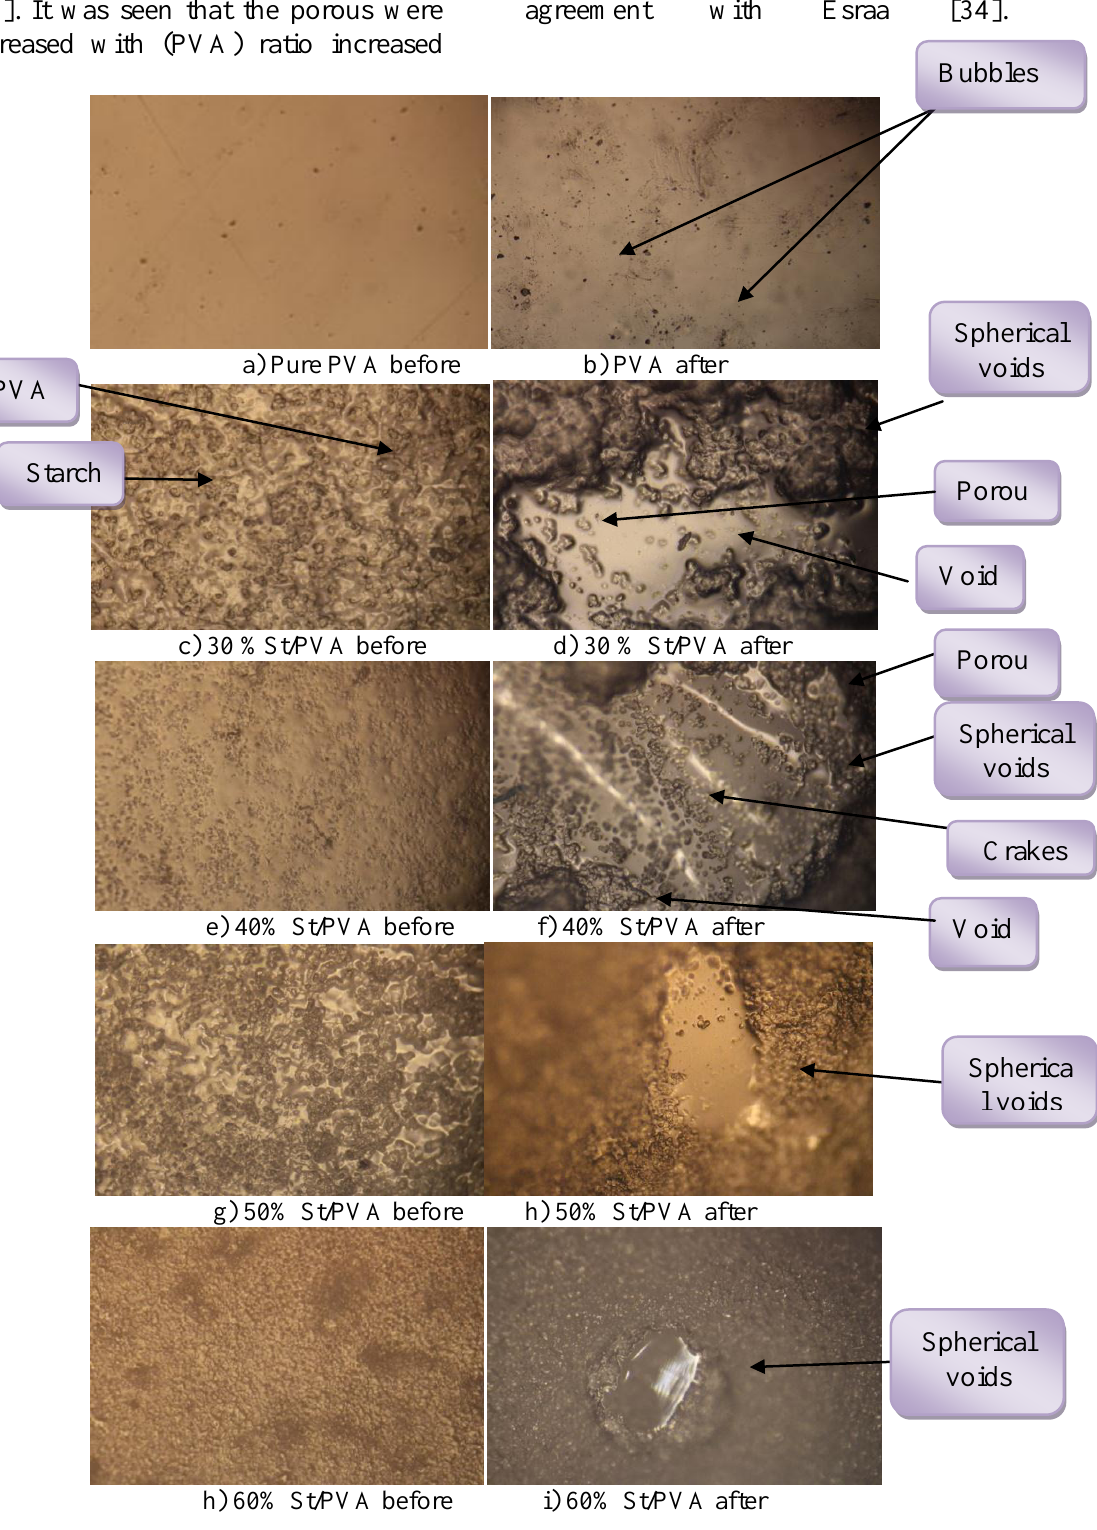
Fig. 11: The optical micrographs of (PVA) and St/PVA blends before and after α-amylase